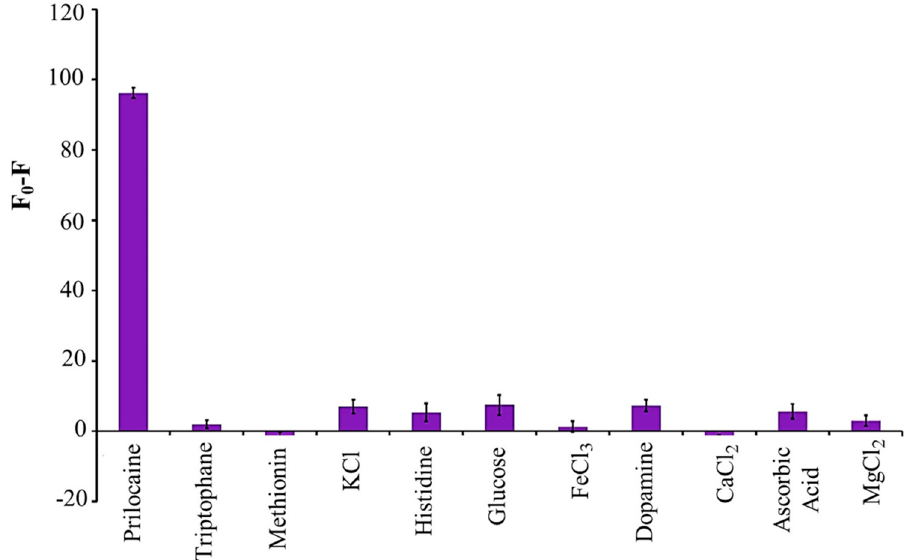
Figure 7. Selectivity calculated as differences between neat and conjugated of the BCCDs reported in [128] for prilocaine in real human blood at pH 4. Picture reprinted with all permissions from Elsevier.